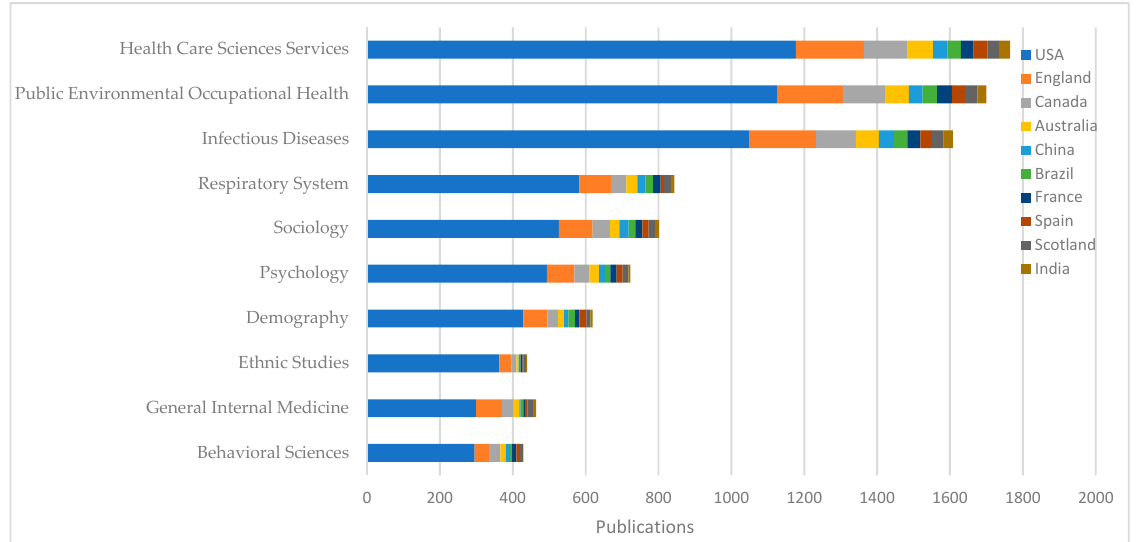
Figure 3. Country or region distribution of each research category.